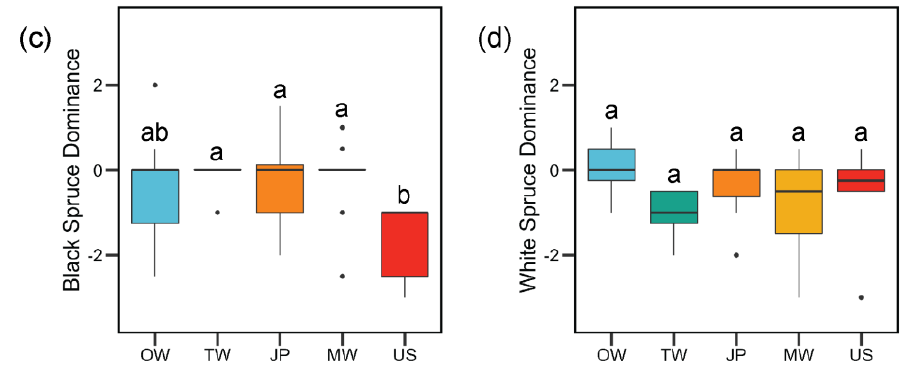
Figure A4. Increases and decreases in post-fire dominance of ( a ) jack pine, ( b ) trembling aspen, ( c ) black spruce, and ( d ) white spruce, within topoedaphic vegetation classes of open wetland (OW; blue), treed wetland (TW; green), upland mixedwood (MW; yellow), upland jack pine (JP; orange), and upland black or white spruce (US; red). Values of 0 indicate no change in dominance, whereas values greater than 0 indicate sites with an increase in dominance post-fire, and those sites that experienced a decline of the species of interest in the post-fire cohort have negative values. Letters above or below boxplots indicate significant differences in least-squares means ( α = 0.05), with a post-hoc Tukey test for multiple comparisons. Table A1. Descriptive multivariable linear mixed-effects models explaining post-fire organic soil depth and soil chemical properties as a function of topoedaphic vegetation classes (TVC) and observed surface burn severity, represented by the Burn Severity Index (BSI). The statistical significance of independent predictor variables in explaining soil properties was determined using an ANOVA considering Type II sums of squares. Significance of independent variables to soil properties is signified as